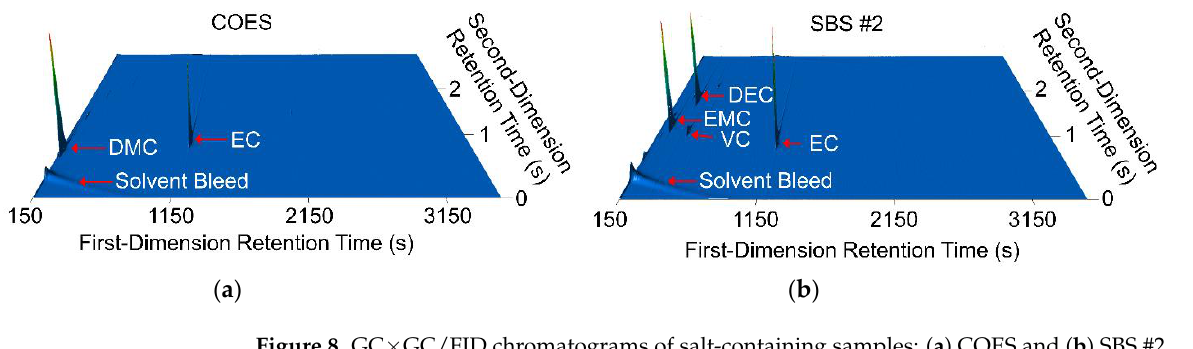
Figure 8. GC×GC/FID chromatograms of salt-containing samples: ( a ) COES and ( b ) SBS #2. Figure 8. GC × GC/FID chromatograms of salt-containing samples: ( a ) COES and ( b ) SBS